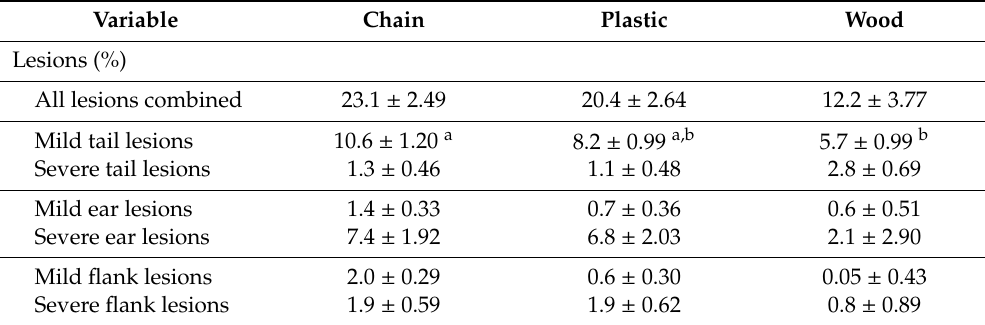
Table 5. Prevalence (LS means ± SE) of lesions associated with damaging behaviours observed in finisher pigs on 29 farms that provided di ff erent types of enrichment (chains, plastic or wooden objects). Di ff erent superscript letters indicate significant di ff erences p <